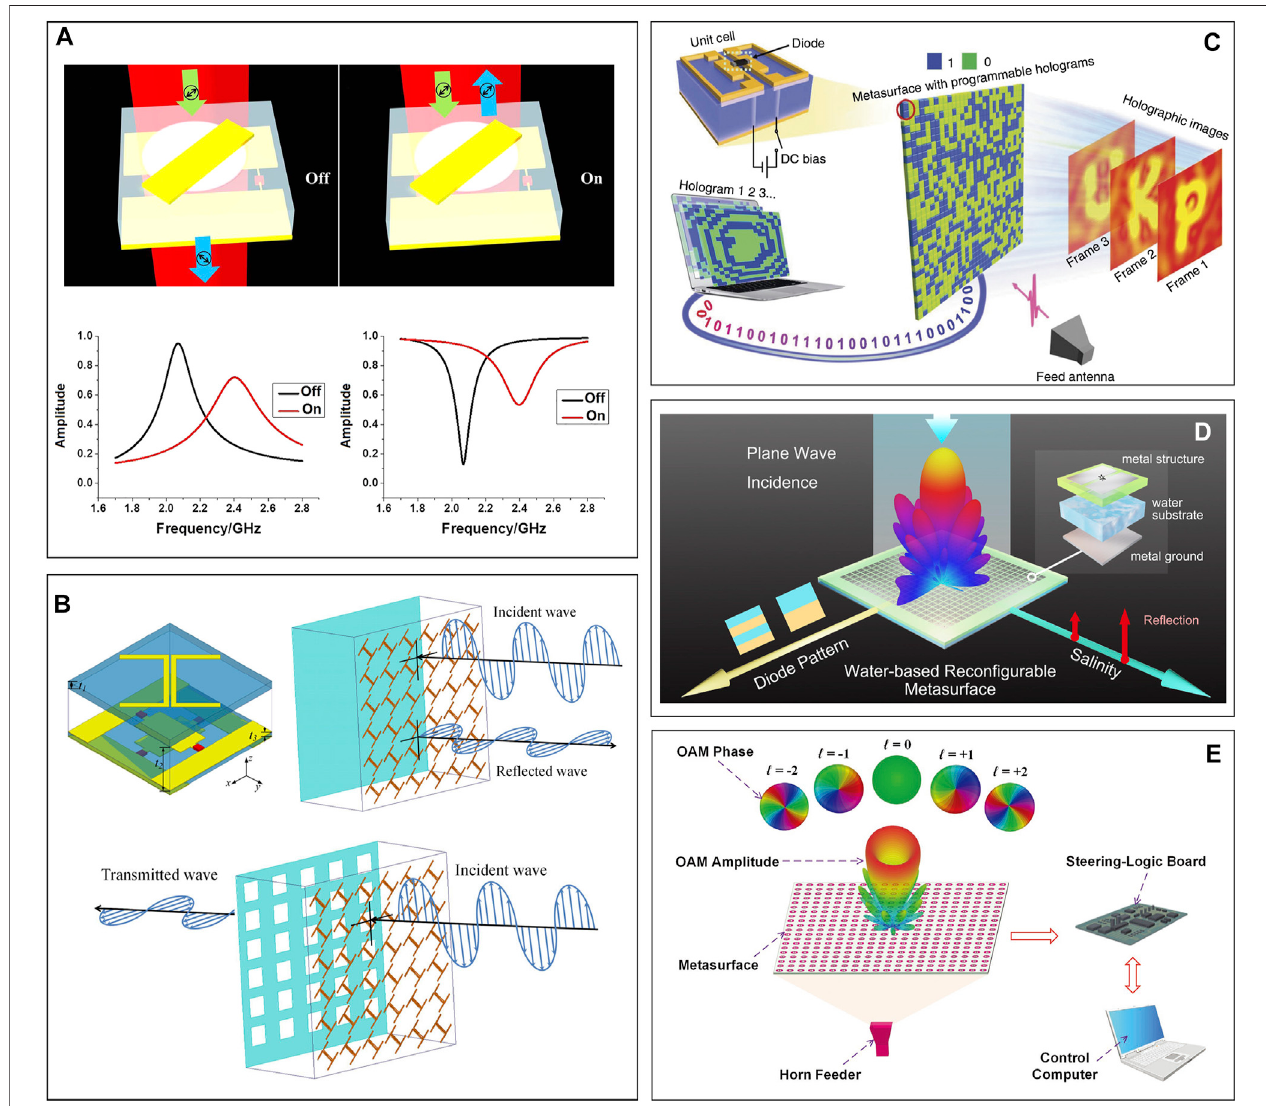
FIGURE 1 | (A) Active metasurface for recon fi gurable transmissions/re fl ections and cross polarization conversions. Reproduced from Tao et al. (2017) with permissionfromAIPPublishing. (B) Recon fi gurablemetasurfaceforpolarizationandpropagationManipulation.ReproducedfromLiY.etal.(2019)withpermissionfrom IEEE. (C) Reprogrammable coding metasurface holograms. Reproduced from Li et al. (2017) with permission from Spring Nature. (D) Recon fi gurable water-based metasurface integrated with PIN diodes. Reproduced from Chen et al. (2019a) with permission from AIP Publishing. (E) Transmissive programmable metasurface for multimode OAM generation. Reproduced from Bai et al. (2020) with permission from John Wiley and Sons.